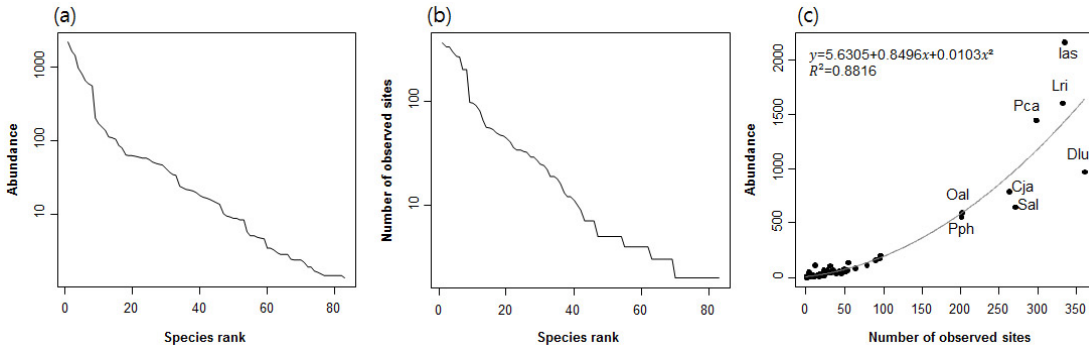
Figure 2. ( a ) Species rank-abundance curve; ( b ) species rank-incidence curve; and ( c ) relationship between species abundance and incidence. Three letters in Figure 2c are abbreviations for the eight dominant species: Ias, Ischnura asiatica ; Lri, Lamelligomphus ringens ; Dlu, Davidius lunatus ; Pca, Paracercion calamorum ; Sal, Sieboldius albardae ; Cja, Calopteryx japonica ; Oal, Orthetrum albistylum ; Pph, Platycnemis phillopoda .